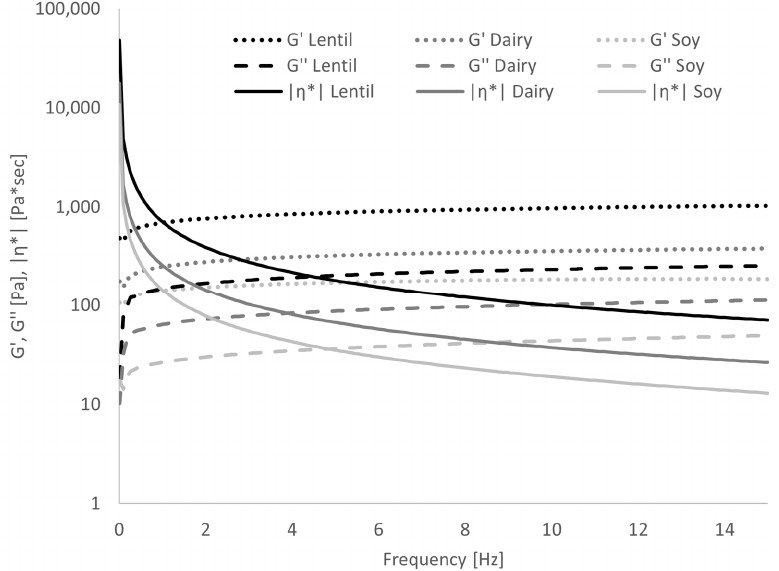
Figure 5. Results of frequency sweep: Dependence of storage modulus G ′ , loss modulus G ″ and complex viscosity | η *| on frequency. Error bars have been omitted for clarity.